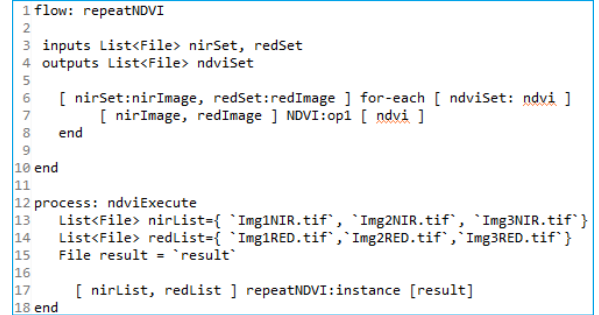
Figure 4. For-each workflow example